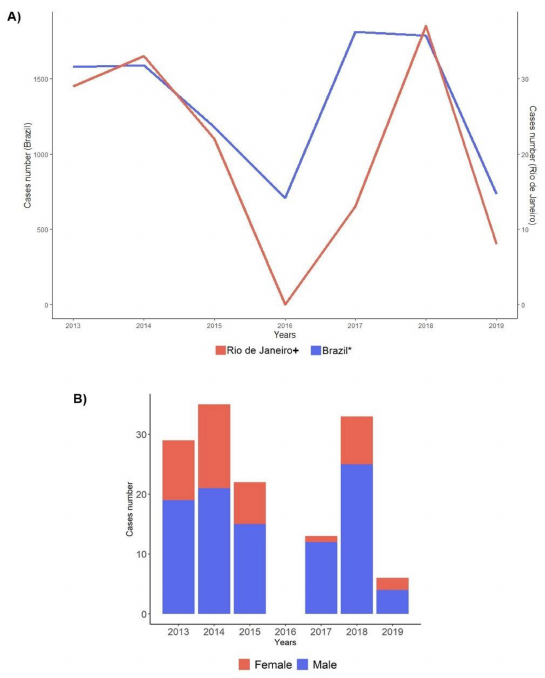
Figure 1. Distribution of notified HAV cases by year and gender per year. ( A ) Distribution of HAV registered cases in adults between 2013 and 2019 in Brazil and at the Viral Hepatitis Clinic/Rio de Janeiro. The blue line represents HAV cases registered in Brazil, and the red line represents cases registered in the Clinic. * Data kindly supplied by the General Coordination of Strategic Information, Department of Chronic Conditions and Sexually Transmitted Infections, Secretariat of Health Surveillance, Brazilian Ministry of Health. + Viral Hepatitis Ambulatory/ Viral Hepatitis Laboratory of the Oswaldo Cruz Institute, Oswaldo Cruz Foundation, Ministry of Health, Rio de Janeiro. ( B ) Gender distribution according to the year for cases followed at the Viral Hepatitis Ambulatory/Viral Hepatitis Laboratory of the Oswaldo Cruz Institute, Oswaldo Cruz Foundation, Ministry of Health, Rio de Janeiro. Blue color for the male gender and red for the female gender.